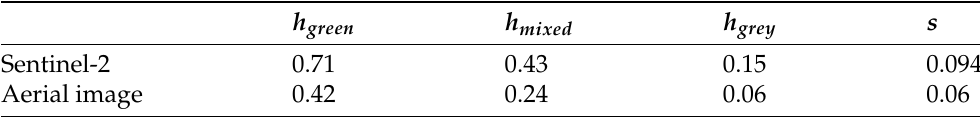
Table 2. NDVI values of cluster centers derived using fuzzy C-means clustering. The shift parameter s was calculated so that m ( { green , grey } ) = 0.5 at h mixed . h green h mixed h grey